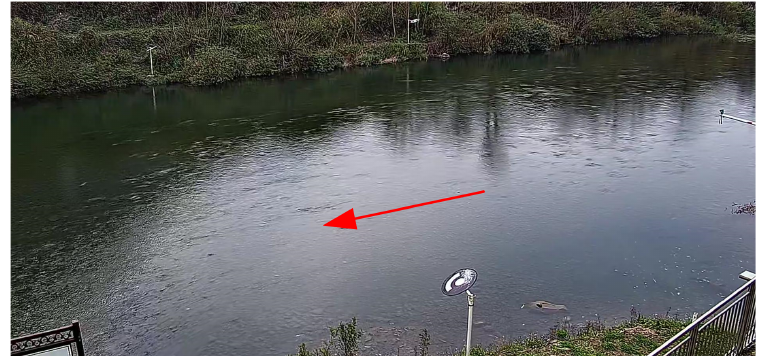
Figure 11. View of camera.